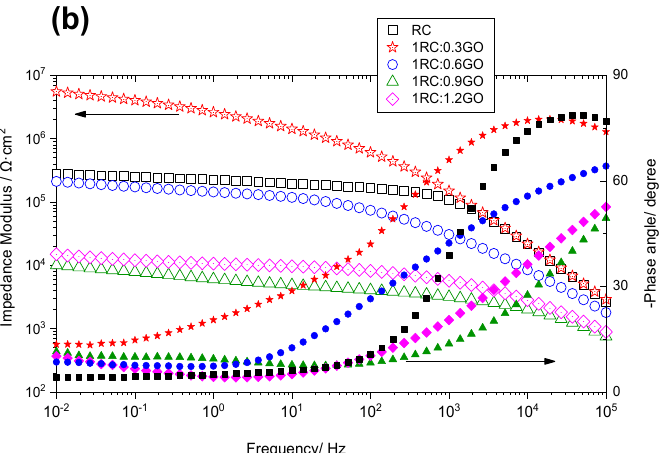
Figure 6. Impedance modulus (open symbols) and phase angle (filled symbols) of the rusted steel coated with the RC/GO formulations after ( a ) 4 days and ( b ) 21 days of immersion in 0.06 M NaCl solution.